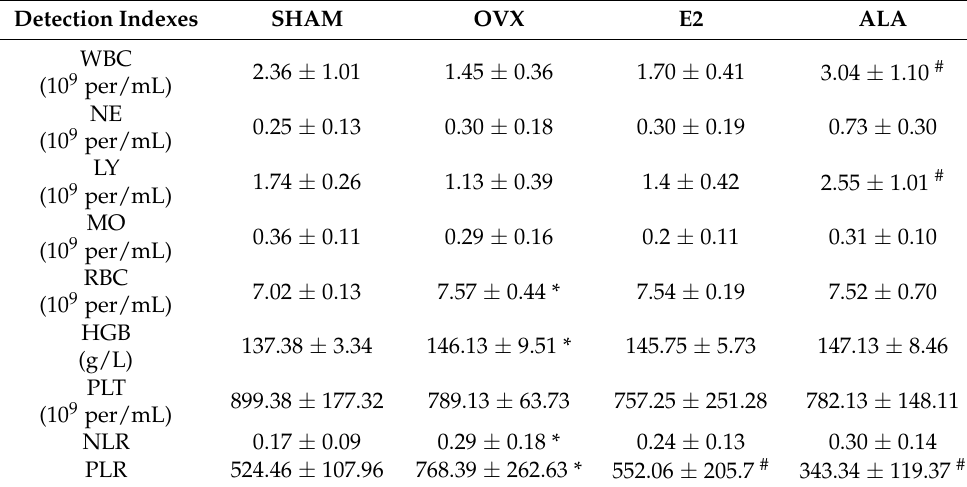
Table 4. Routine blood indexes in different rat groups with therapeutic